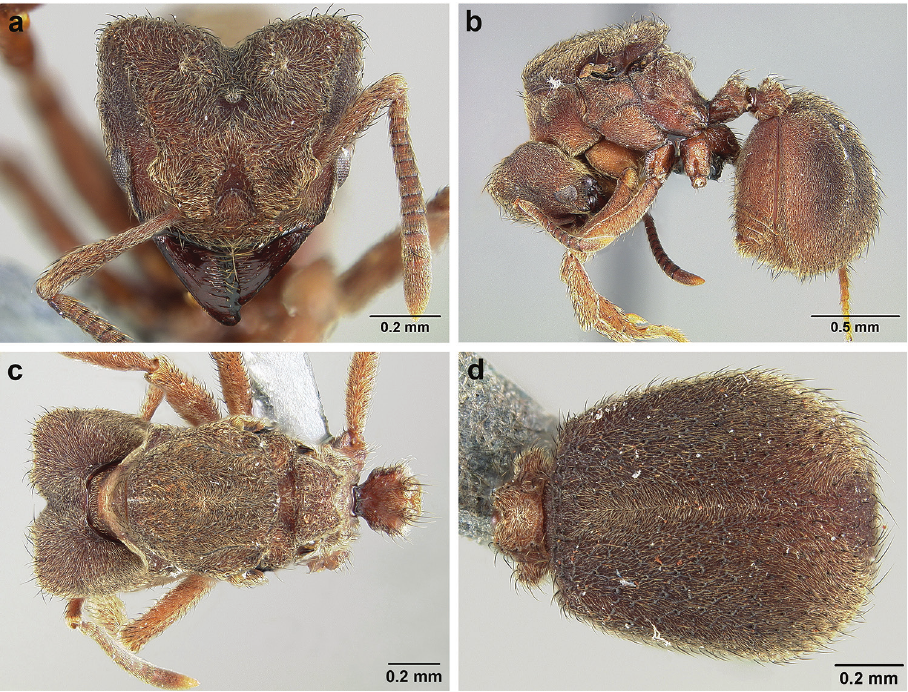
Figure 25. S. bondari queen (USNMENT01125803). a Head b lateral profile c mesosoma, dorsal view d metasoma, dorsal